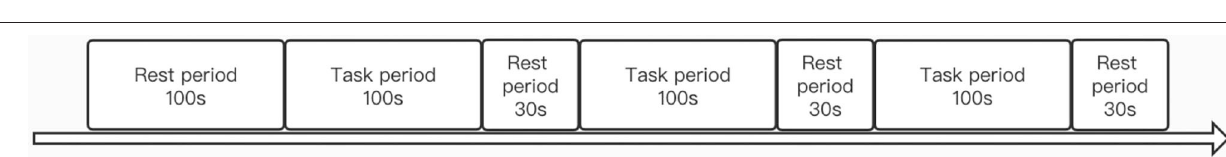
FIGURE 2 | Task flow diagram of fNIRS.